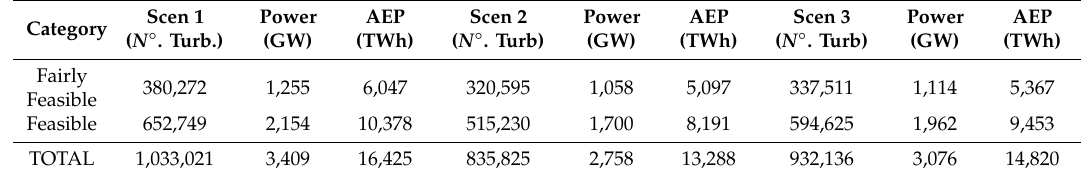
Table 8. Viable number of turbines and power per feasibility area and annual energy production